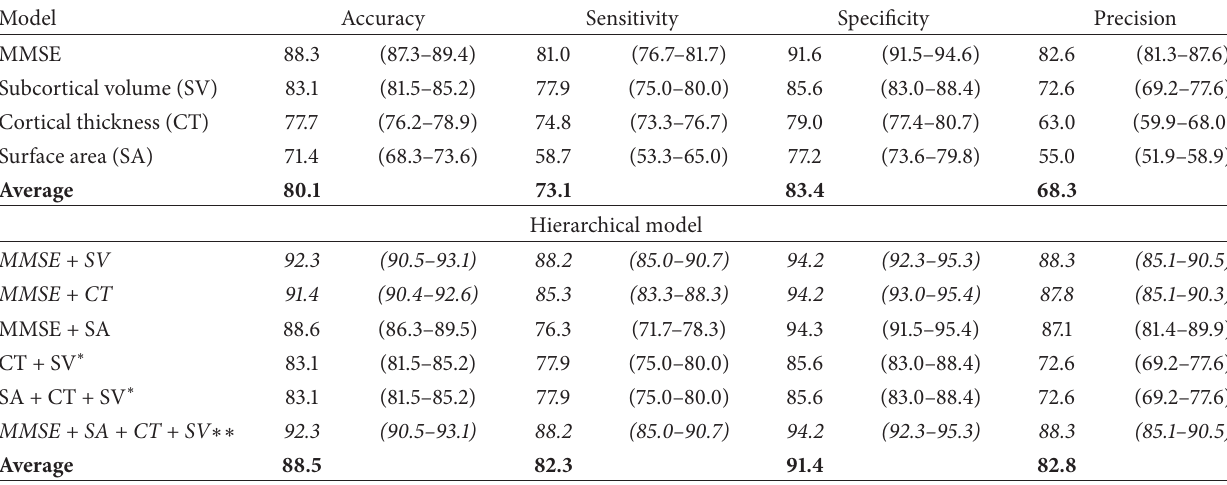
Table 3: Classification performances on raw data.